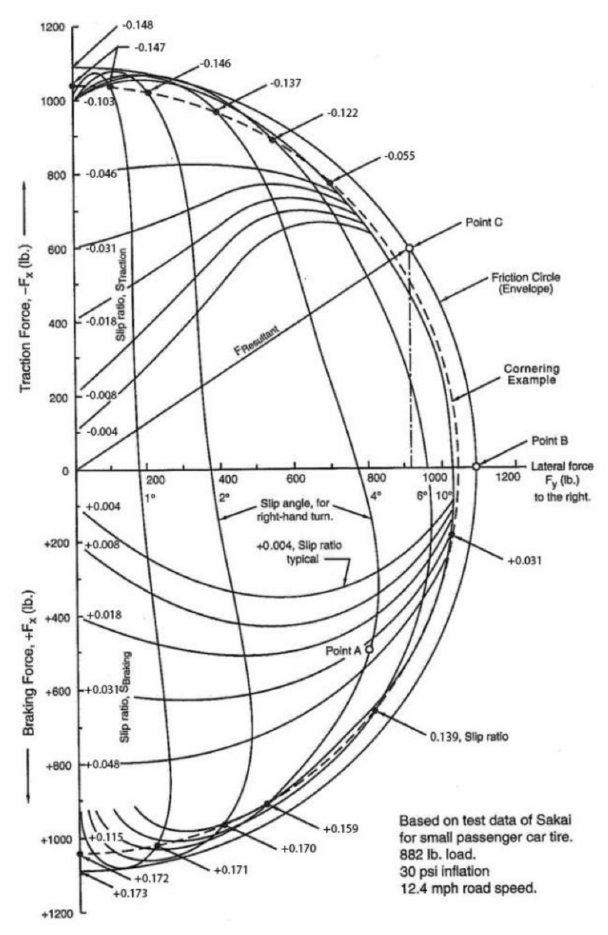
Figure 3. Tire force friction